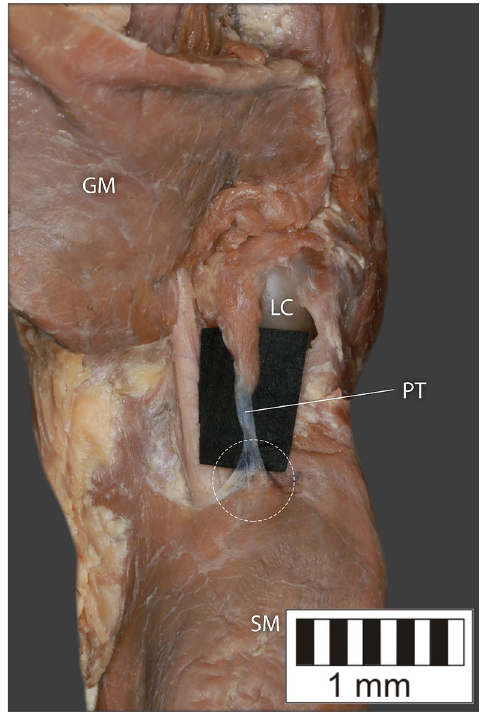
Figure 11. Type VIII of plantaris tendon. SM soleus muscle, GM gastrocnemius muscle, PT plantaris tendon, LC lateral condyle.